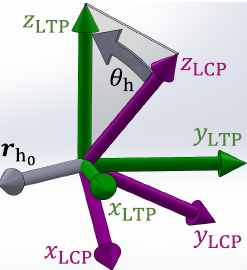
Figure 2. Shown is a rotation around an arbitrary axis to align the z LCP axis with the z LTP axis. The axes of the LTP are shown in green, the axes of the LCP are shown in magenta, and the arbitrary axis r h and the rotation angle θ h with 0